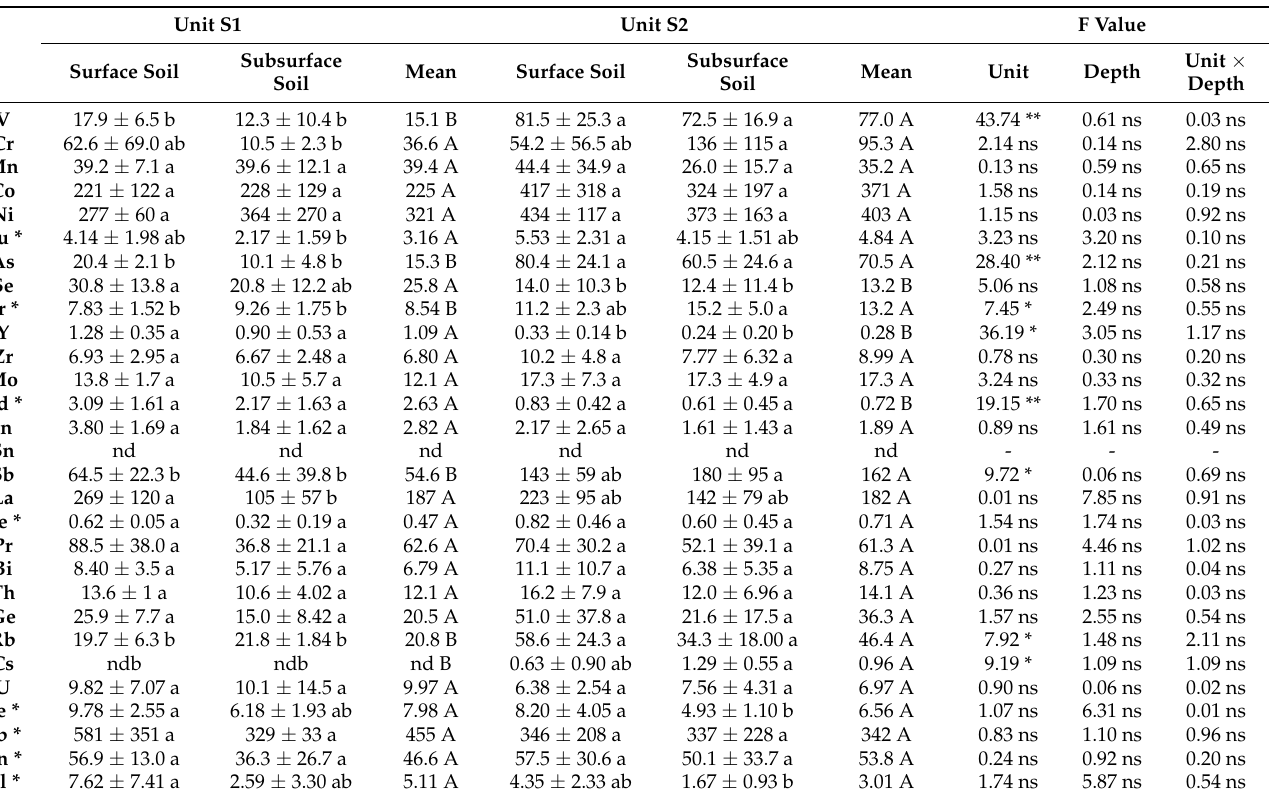
Table 3. Available concentrations of metals and REEs (mg kg − 1 ) in surface (0–15 cm) and subsurface (15–30 cm) soils from Units S1 and